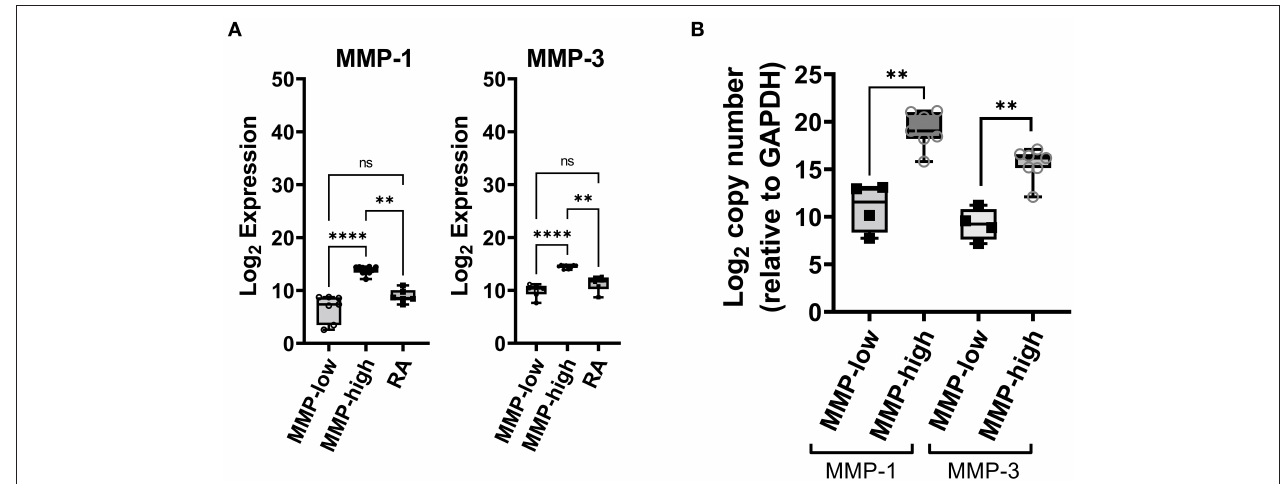
FIGURE 1 | Analysis of synovial gene expression in DMARD-naïve EIA patients— (A) Box-whiskers plot showing the abundance MMP-1 and MMP-3 transcripts between DMARD-naive (MMP-low, MMP-high) EIA patients and advanced RA patients. Transcript abundance was determined by microarray chips. Data is presented as log 2 expression values and analyzed using Kruskal-Wallis test with a Dunn’s post-hoc test. **** P < 0.0001, ** P < 0.01, ns, non-significant. (B) Box-whiskers plot showing mRNA expression of MMP-1 and MMP-3 between MMP-high and MMP-low groups. Data was generated using qPCR, presented as log 2 copy number and analyzed by Mann-Whitney test. ** P <